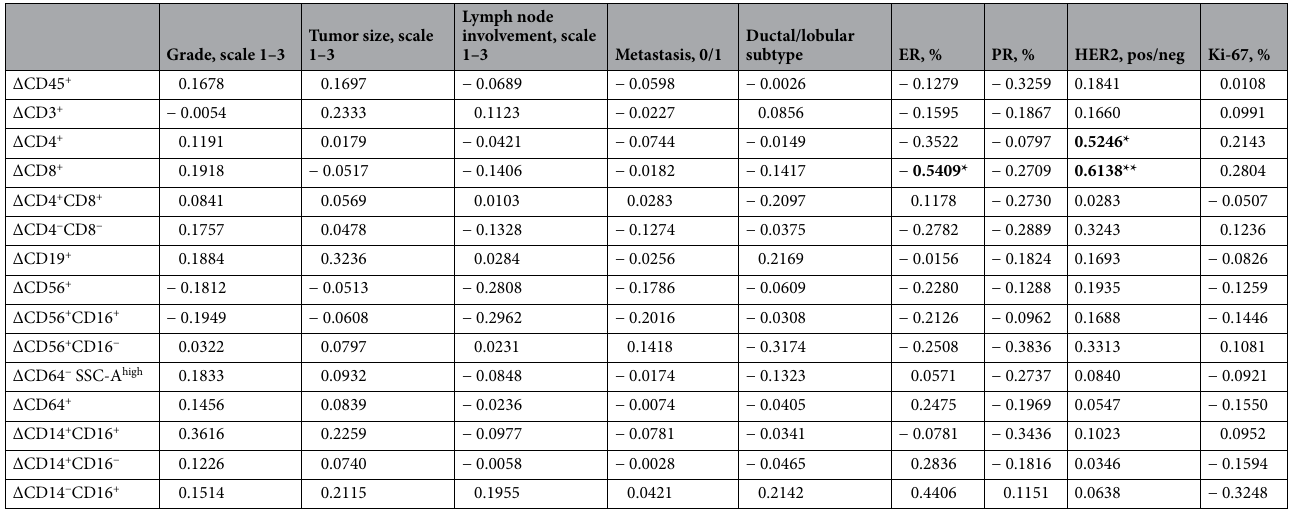
Table 3. Pearson correlation between disease status and change in the cell number between rest and exercise. Significant p values; * < 0.05, ** < 0.01. ER estrogen receptor; PR progesterone receptor; HER2 human dermal growth factor receptor-2; KI-67 proliferation index protein. Significant values are in [bold].